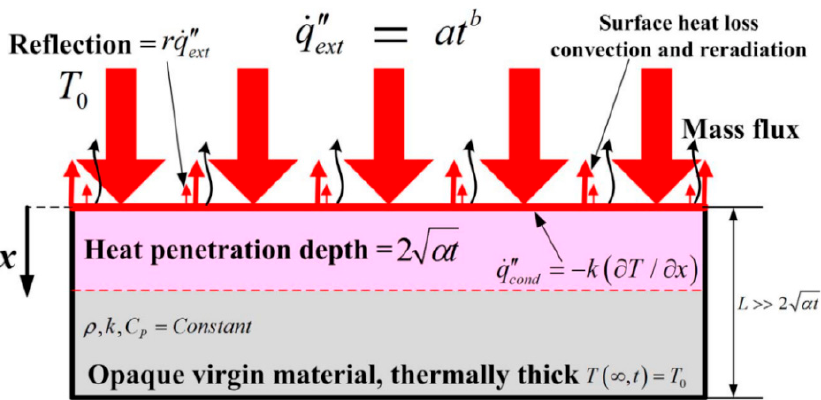
Figure 5. Sample heat transfer progress under rising heat flux [56].